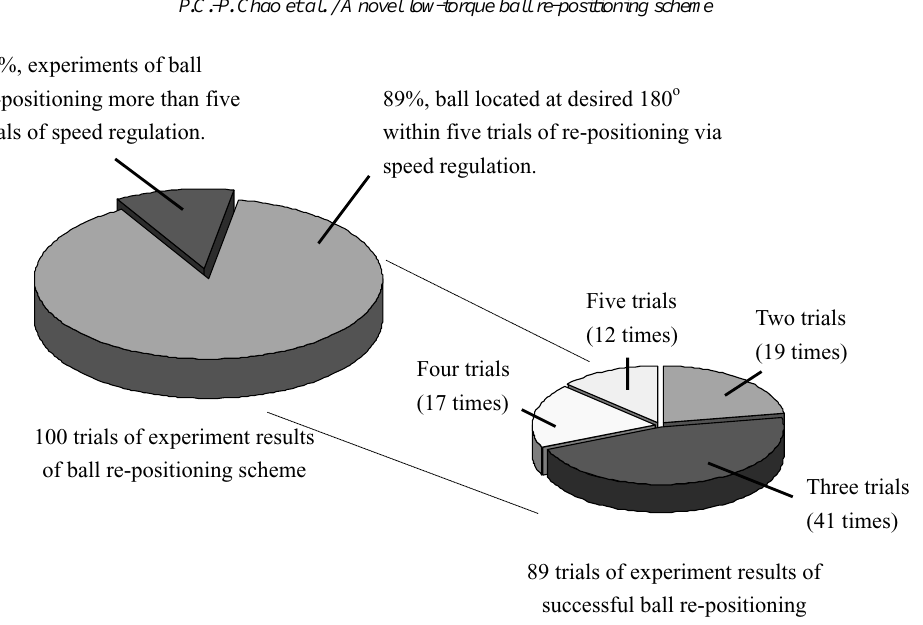
Fig. 18. Distribution of speed-drop trials via the low-torque speed regulator with operation speed at 2600